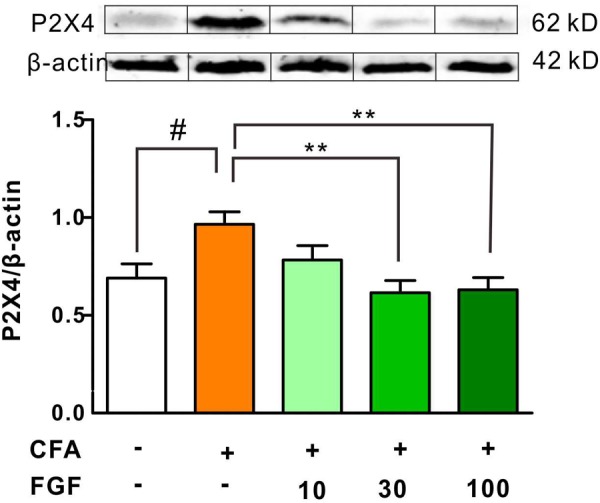
FGF decreased the P2X4 protein expression in the spinal cord of CFA-inflamed mice. The protein levels of P2X4 receptors in the lumbar spinal cord were evaluated by western blot. The top panel: representative western blot images indicating the P2X4 and β-actin protein bands. The bottom panel: quantification of the fold change of P2X4/β-actin. One-way ANOVA and Bonferroni multiple comparison tests as post hoc analyses were used (n = 5–6 per group). #, ## vs. controls and ∗, ∗∗, ∗∗∗ vs. CFA-treated animals. One symbol, p < 0.05; two symbols p < 0.01; three symbols p < 0.001.